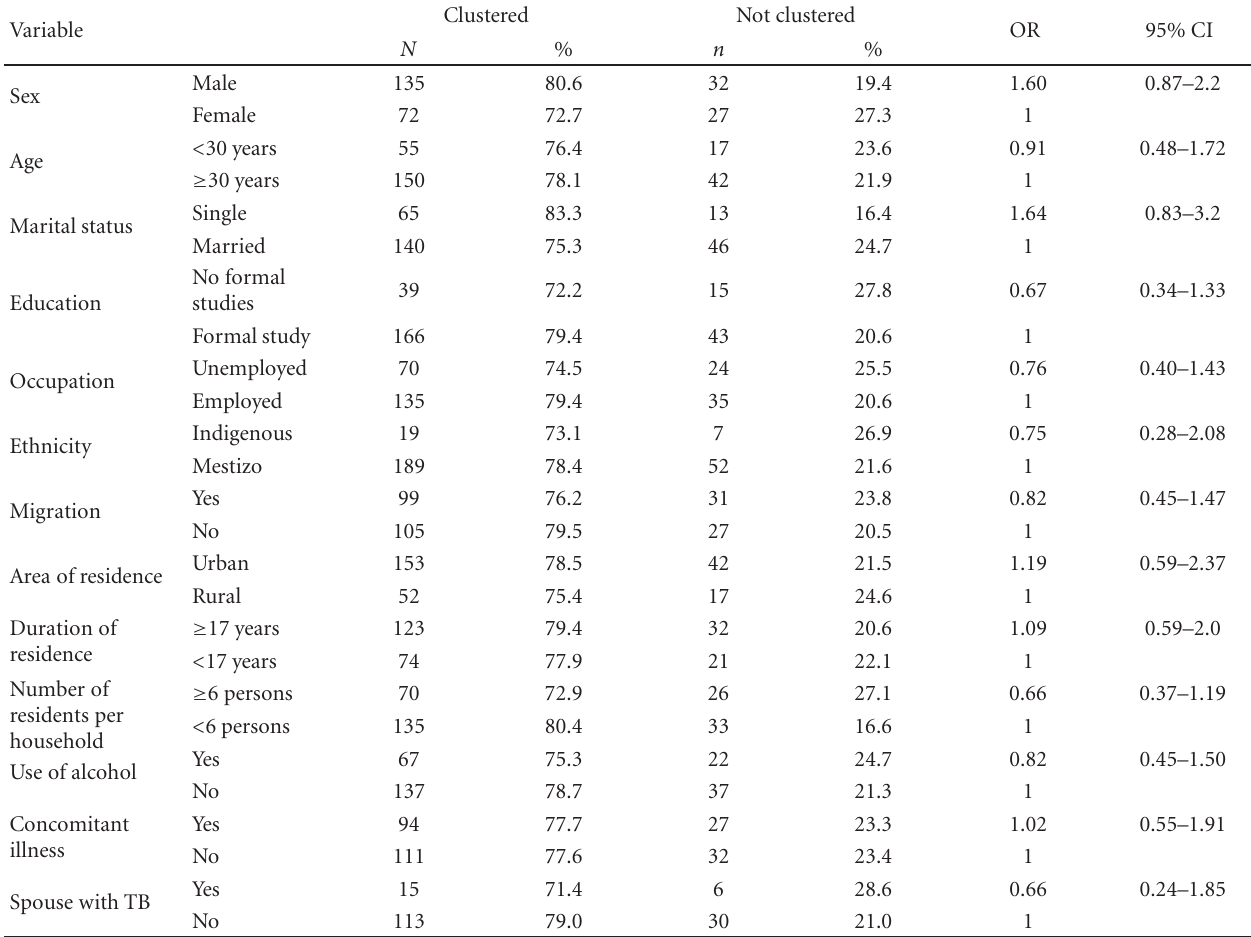
Table 5: Bivariate analysis of conventional TB risk factors, contrasting clustered and nonclustered cases.